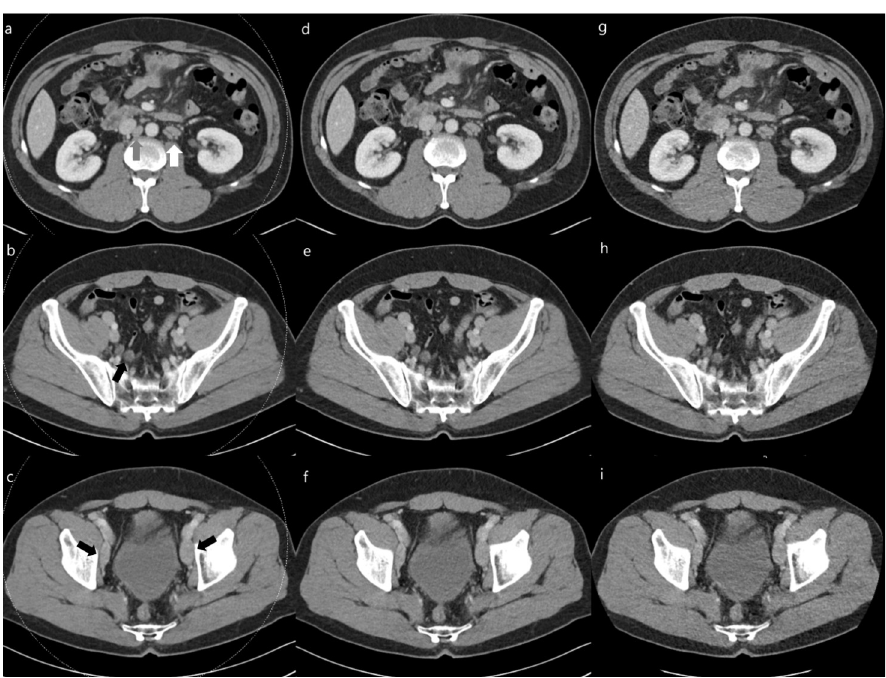
Fig 3. Abdominopelvic computed tomography (CT) images of a 54-year-old man with follicular lymphoma, partial response state (body mass index, 29.4 kg/m 2 ; effective diameter, 27.0 cm). The three different types of CT images, acquired according to the radiation dose (a-c: standard-dose CT, 6.8 mSv; d-f: low-dose CT, 4.5 mSv; g-i: ultralow-dose CT, 2.3 mSv), show multiple enlarged paraaortic (white arrow), aortocaval (gray arrow), right common iliac, and bilateral external iliac lymph nodes (black arrows). Identical findings for the aforementioned lesions were reported by two radiologists. The overall image quality score was 4 for ultralow-dose CT images and 5 for low-dose and standard-dose CT images, according to two radiologists; the image quality score was 5 for all the three types of CT images according to one hematologist.